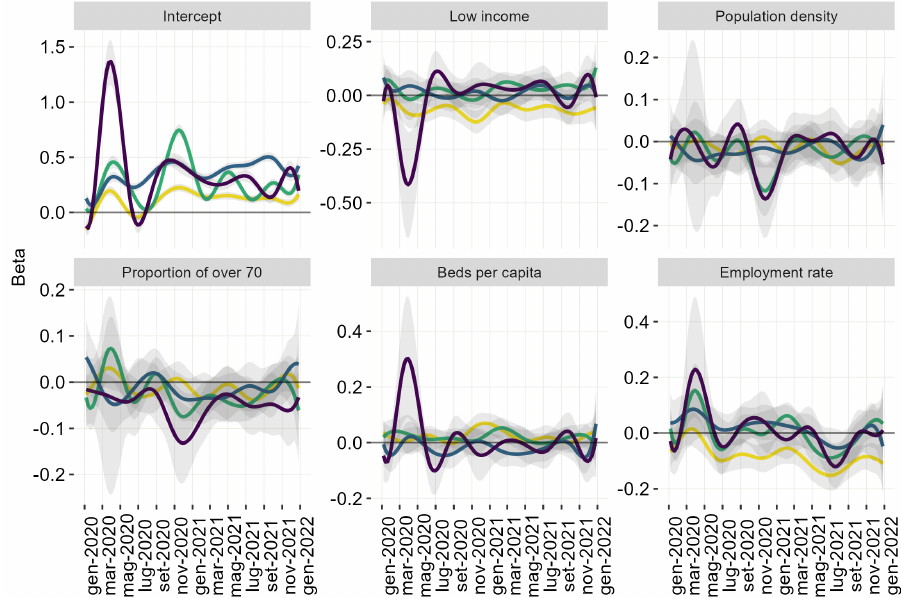
Figure 3. Estimated functional coefficients. The colour of the curves follows the colours of the clusters, namely, yellow—Cluster 1, green—Cluster 2, blue—Cluster 3, and violet—Cluster